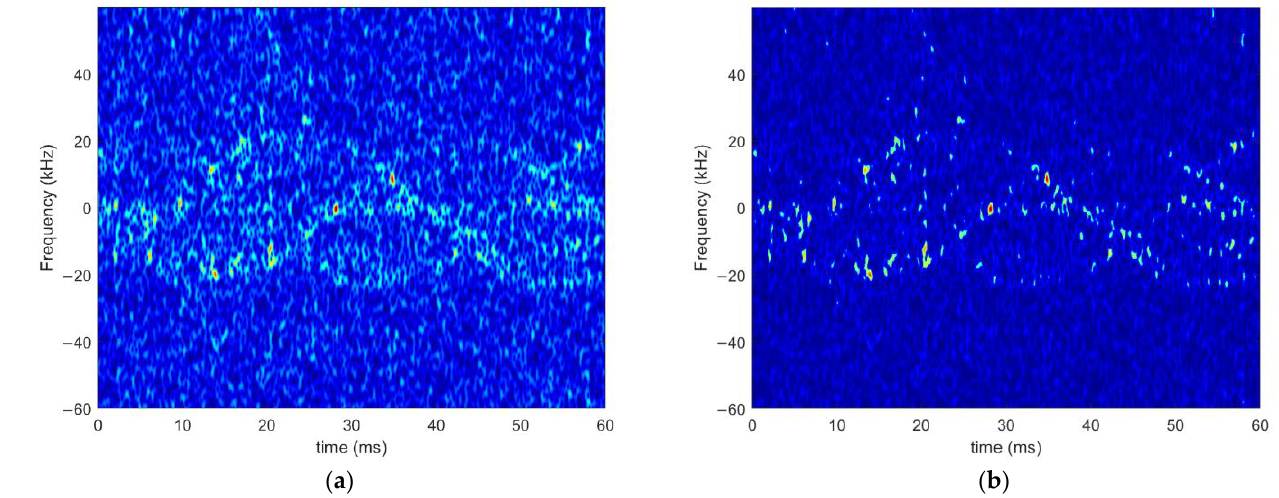
Figure 11. Time – frequency distribution of turbine echo (SNR = 5 dB): ( a ) Before enhancement of wavelet coefficients. ( b ) After enhancement of wavelet coefficients.